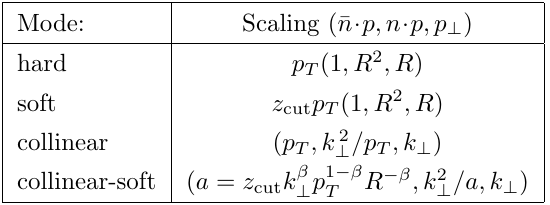
Table 2 . For the angle between the GR and WTA axis, the modes that enter in the factorization of the jet function when k z cut p T R are listed G ? (cid:28)